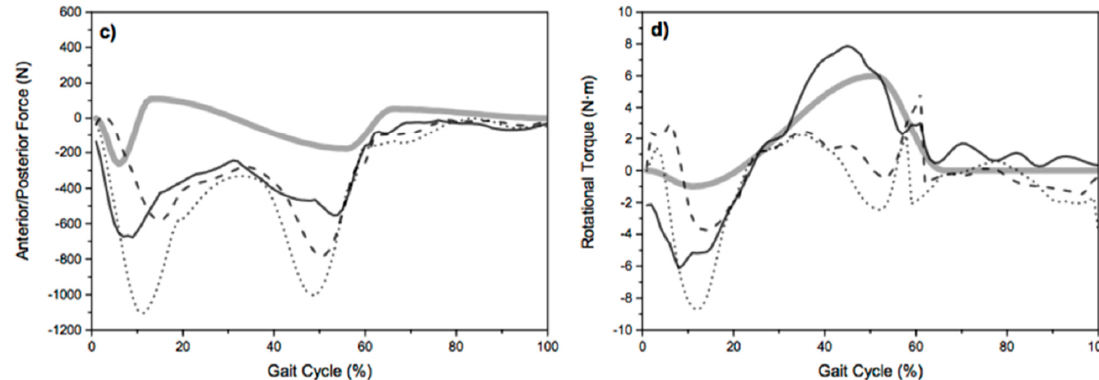
Figure 2. Comparison between in silico: flexion / extension angle ( a ), axial force ( b ), anterior / posterior force ( c ), and rotational torque ( d ) from three gait types and the ISO 1423-3 values. The resultant simulated force is shown in Figure 3. It is possible to observe a good correlation with experimental measures for both Magnitude and Phase errors (M and P coe ffi cient are always less than 0.2). Regarding the resultant moment (Figure 3), the magnitude error for “Gait Normal” and “Gait Fast” is higher than 0.4, indicating that simulated resultant moment is greater.